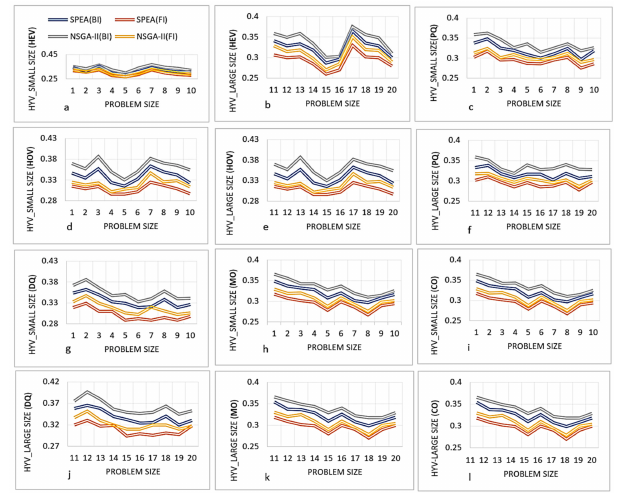
Figure 9. Hypervolume (HyV) scores for small and large problem instances of Heterogeneous vehicles ( a , b ), Homogeneous vehicles ( d , e ), perfect-quality products (PQ) ( c , f ), di ff erent-quality products (DQ) ( g , j ), monitoring only (Mo) ( h , k ) and conformity only (Co) ( i , l ).